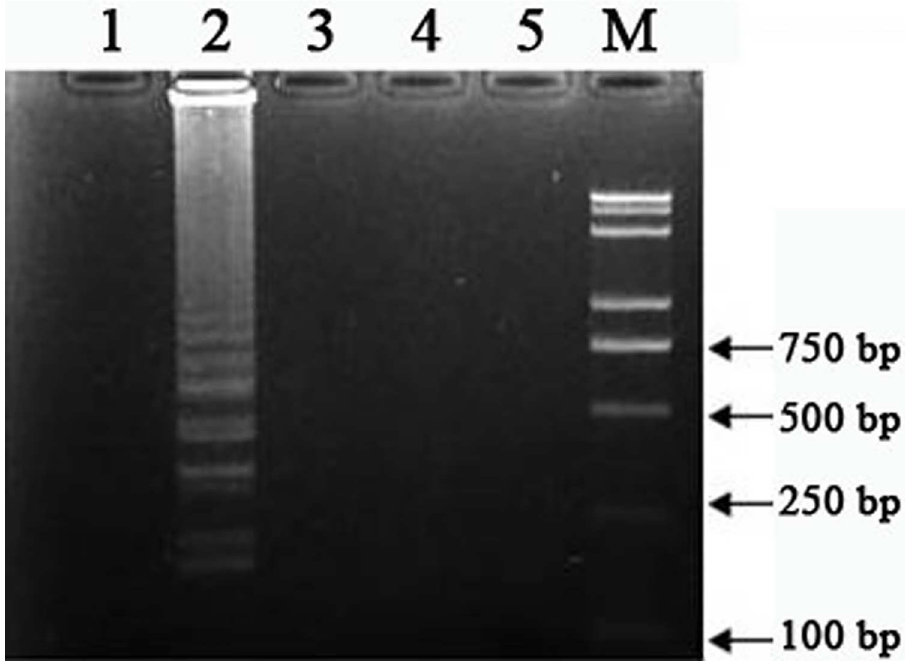
Fig 2. Specificity of LAMP. LAMP reactionwas monitoredfor DNA amplification of Eimeriatenella (lane 1) , Toxoplasma gondii(lane 2) , Trypanosoma evansi (lane 3) , Cryptosporidium parvum (lane 4) and Neosporacaninum (lane 5) by gel electrophoresis. Lane(M), DNA ladder.